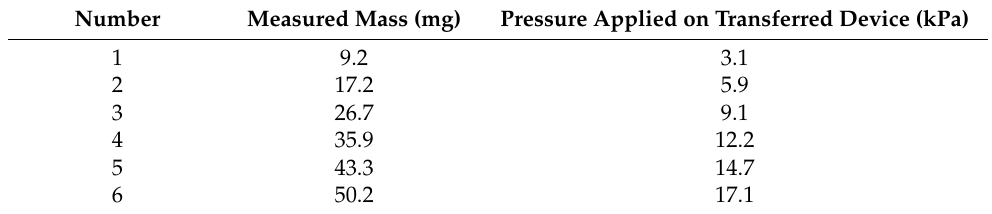
Figure 14. Tip of the copper wire weight. ( a ) The tip of the copper wire weight is hard and uneven; ( b ) The 1.2 µ m-thick silicon nitride diaphragm is damaged during the test; ( c ) The layer of CRC PLASTICOTE 70 clear protective lacquer coated on the surface of the cured silicon adhesive sealant prevents the 1.2- µ m-thick silicon nitride diaphragm from being damaged during the test; ( d ) The 1.2 µ m-thick silicon nitride diaphragm is not damaged after the test. Table 1. Different masses of the beam-shaped copper wire weights measured by Mettler Toledo